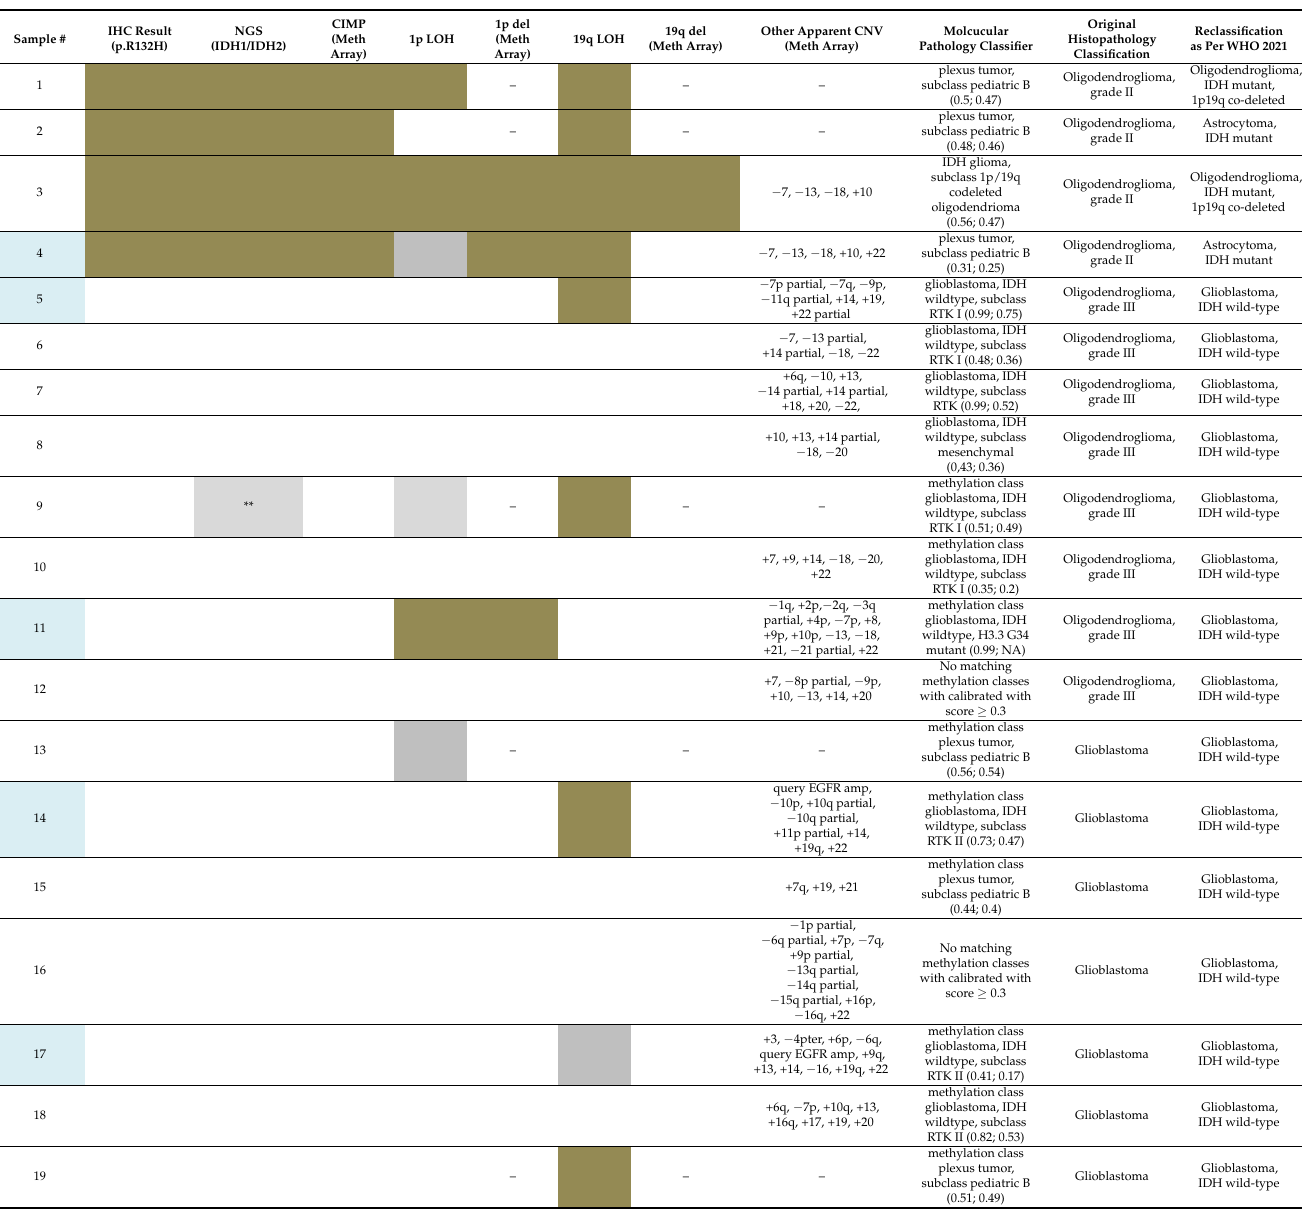
Table 2. Tumor reclassification based on histological, molecular, and epigenetic findings. Molec- ular testing results for each case are provided, including IDH1 p.R132H immunohistochemistry, IDH1/IDH2 sequencing, CIMP positivity (as determined by hierarchical clustering, using the top 11 CpG sites that were differentially methylated) and 1p/19q status (based on single analyte testing and WGMA). Replication cohort samples are underlined. Tumor classifications as as- sessed using the MolecularNeuro-pathology.org Classifier (v11b4, accessed on 27 July 2020) are provided; calibrated scores for class and subclass are shown in brackets (recommended score class: >0.90, subclass > 0.5). Original tumor classifications as assessed by two senior neuropathol- ogists are also provided. Histological criteria used for the original classifications include: oligo- dendroglioma grade II—no necrosis or microvascular hyperplasia (mvh); oligodendroglioma grade III—necrosis/mvh, increased mitotic activity; astrocytoma grade II—no necrosis/mvh or increased mitotic activity; astrocytoma grade III (anaplastic astrocytoma)—increased mitotic ac- tivity/anaplasia, no necrosis/mvh; glioblastoma—morphologically astrocytic with necrosis/mvh; oligoastrocytoma—morphologically mixed oligo/astrocytic, no necrosis/mvh or increased mitotic activity; oligoastrocytoma grade III—with anaplasia, increased mitotic